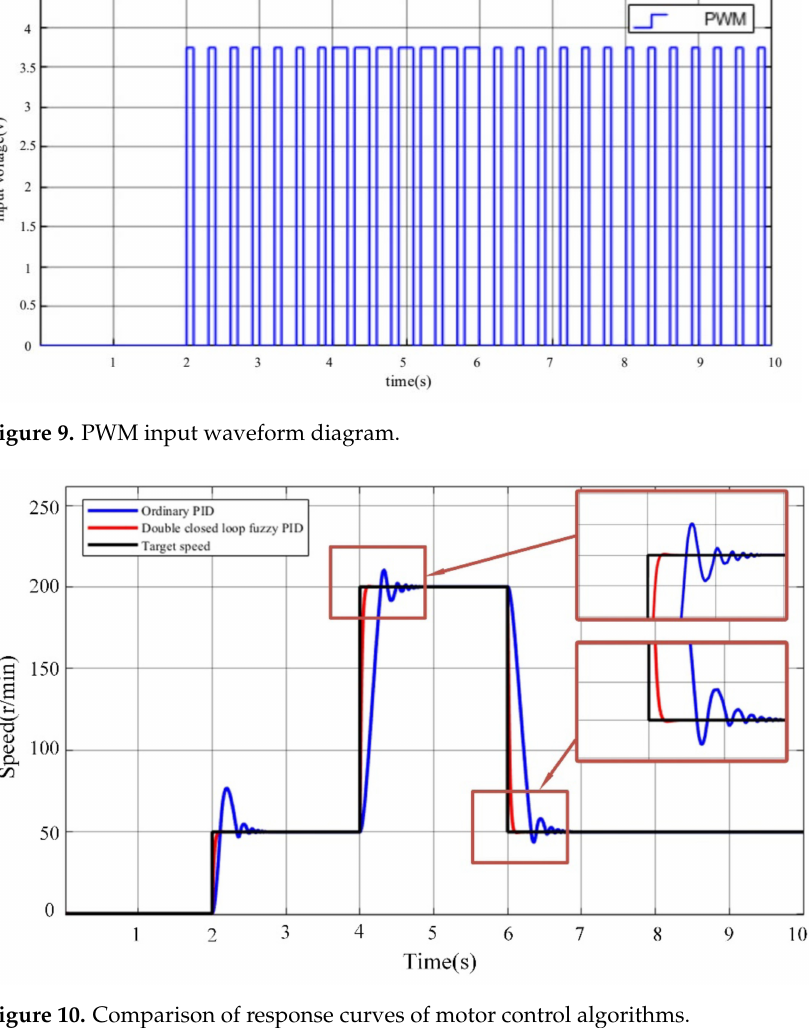
Figure 10. Comparison of response curves of motor control